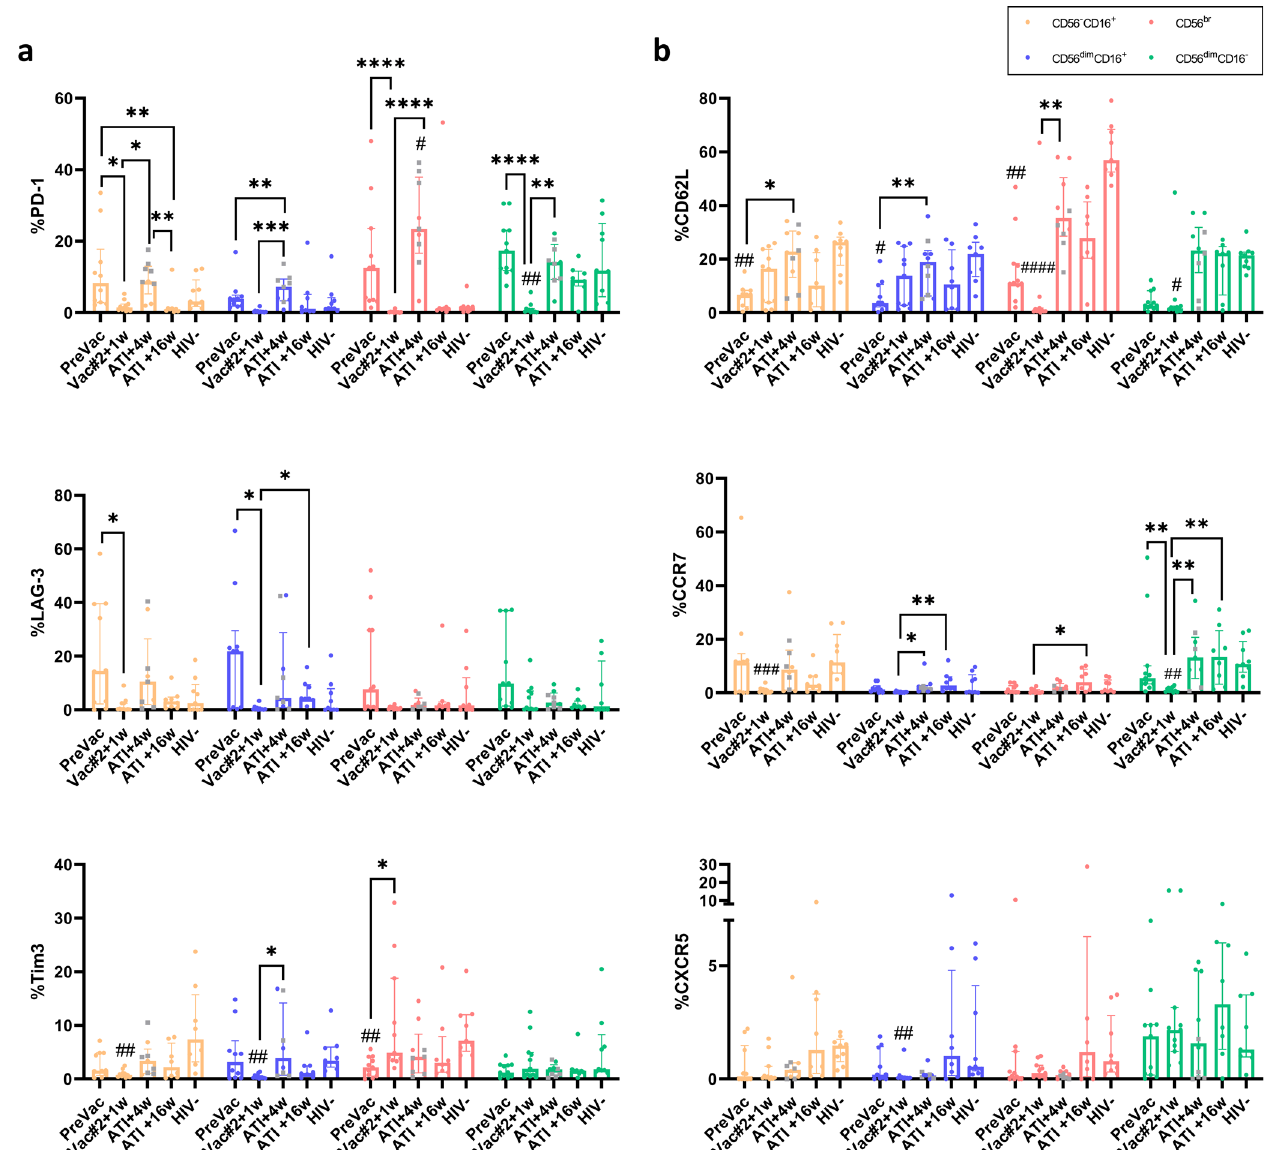
Fig. 4 Migratory and exhaustion pro fi le of NK cells during the course of the DC-TRN trial. Percentage of NK cell subets expressing the markers involved in ( a ) exhaustion and ( b ) homing to LN follicles in participants during the trial and in HIV-1 − individuals. Median ± IQR; Kruskal – Wallis test with Dunn ’ s multiple comparisons test to compare the studied time points and HIV-1 − individuals within the different NK cell subsets. Participants that rebounded at ATI + 4w are indicated with a grey square. Comparison between participants that rebounded at ATI + 4w or not was performed using Mann – Whitney U -test. Signi fi cant differences between the studied time points are graphically annotated with ‘ * ’ as follows: * p < 0.05, ** p < 0.005, *** p < 0.001 and **** p < 0.0001. ‘ # ’ indicate a signi fi cant difference compared to HIV-1 −